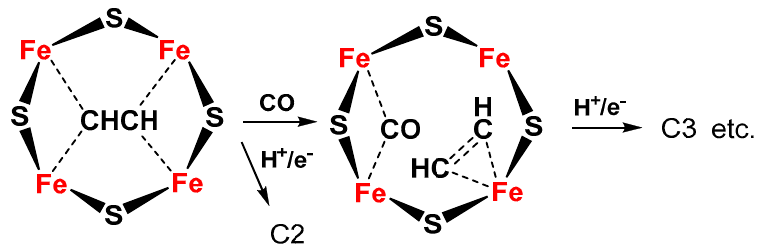
Figure 4. Proposed schematic mechanism of the active sites in FeMo cofactor for conversion of C2 intermediate to C3 products (hydrocarbon, oxygenates) via formation of a ferracycle species.